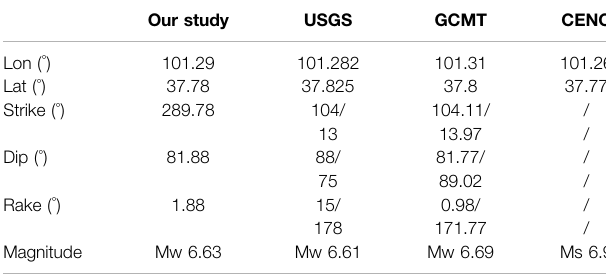
TABLE 1 | Source and fault parameters of the 2022 Menyuan earthquake. Our